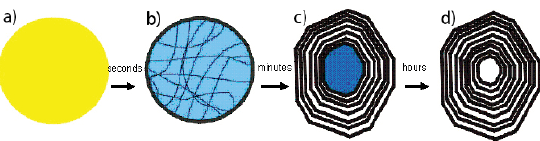
Scheme 1. Schematic depiction of the growth mechanism of IF-